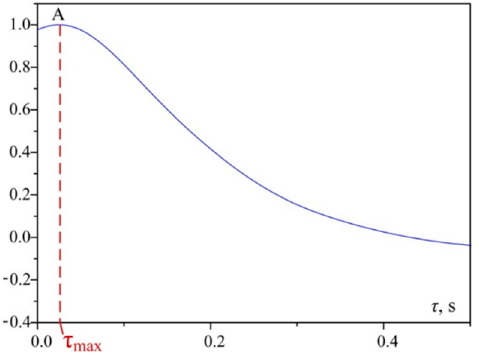
Figure 6. Cross-correlation function of the two temperature signals.